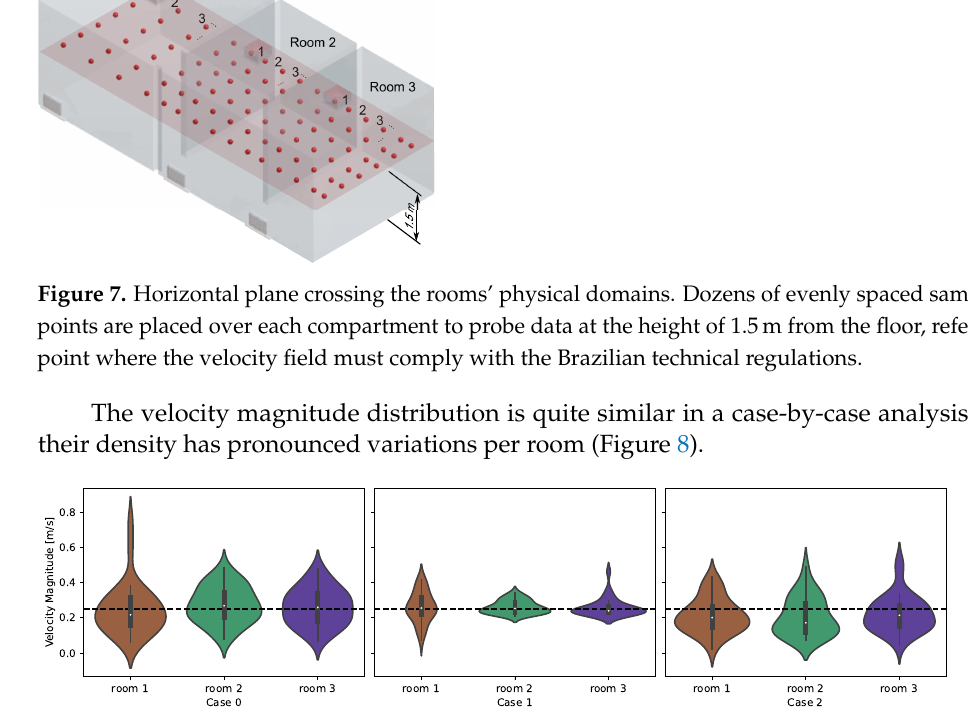
Figure 8. Violin plots describing the density of the velocity field’s distribution (magnitude measured according to the usual Euclidean norm). From left to right, the boxed figures represent the cases studied (0: no filter; 1: 1 (cid:48) filter; 2: 2 (cid:48)(cid:48) filter), organized per